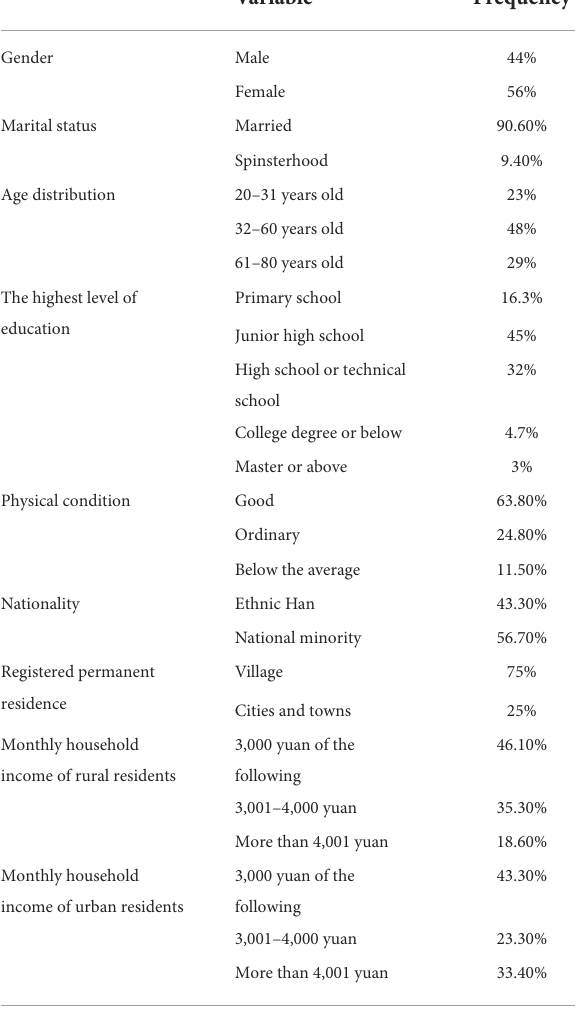
TABLE 3 Composition of